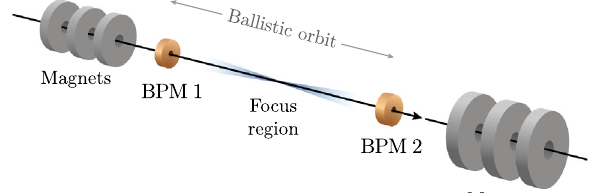
FIG. 2. Basic experimental setup, with two BPMs surrounding the focus region, separated by a ballistic orbit. The measurement can also be generalized to nonballistic orbits, where there are magnets also between the